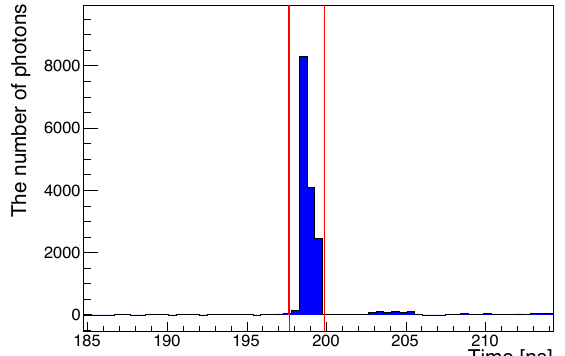
Figure 7. Arrival time distribution of FWM photons via the atomic process when a BBO crystal was placed at IP and space–time synchronization was ensured by PMT1. The red lines thus provide the expected time window for FWM photons via ALP-exchange to